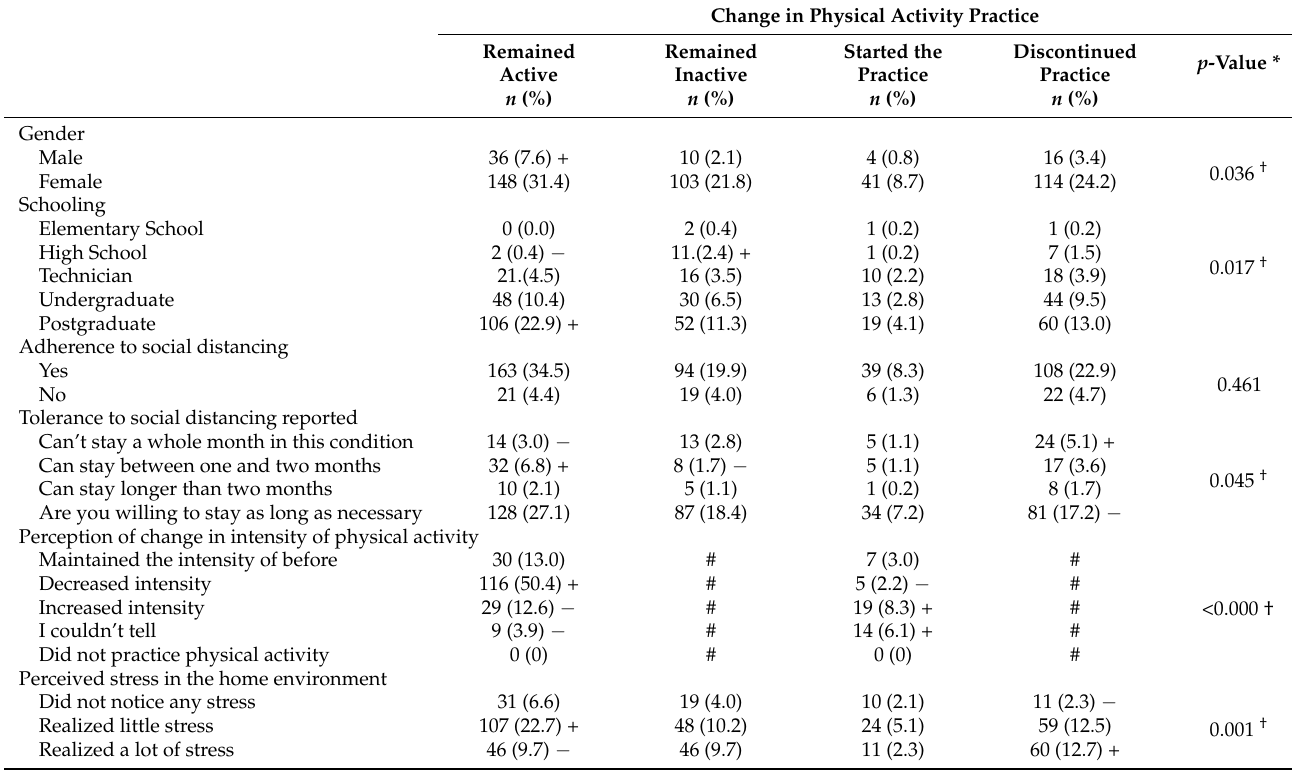
Table 4. Association between sociodemographic characteristics and social isolation with the practice of physical activity of individuals with type 1 diabetes during the COVID-19 pandemic in